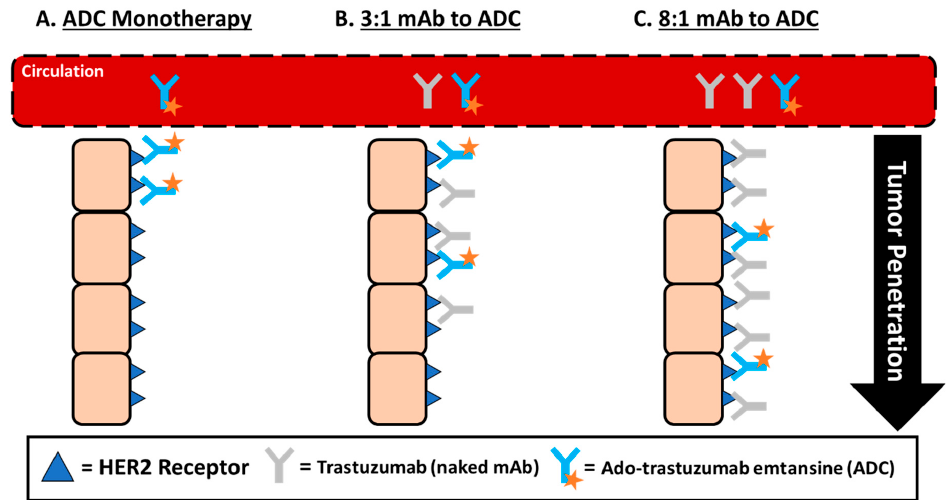
Figure 3. Improved ADC tumor penetration by administering ADC in combination with naked antibody carrier. ( A ) The tumor distribution of ado-trastuzumab emtansine monotherapy administered at 3.6 mg/kg results in only perivascular tumor distribution due to rapid binding after being transported into the tissue from systemic circulation. (B & C) Improvement in the tumor penetration of ado-trastuzumab when co-administered with trastuzumab at a dose sub-saturating or saturating dose of trastuzumab. In theory, these results are due to trastuzumab competing for binding sites, requiring ado-trastuzumab emtansine to penetrate further into tumors to find available binding sites (tumor specific effect) or due to trastuzumab reducing the uptake of ado-trastuzumab emtansine by the mononuclear phagocyte system (MPS) and increasing the serum exposure, which is associated with the greater tumor delivery that has been reported for nanoparticles (NP) agents (reduced systemic clearance effect).